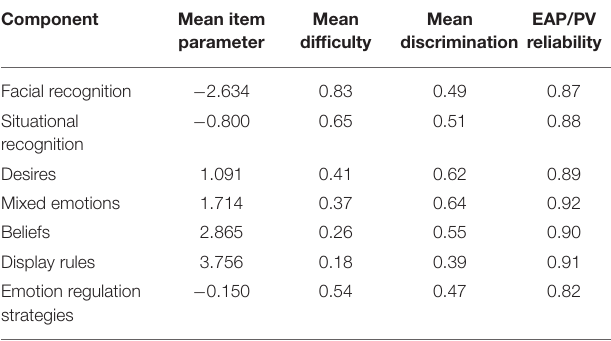
TABLE 6 | Mean item characteristics for the components of the ATEM